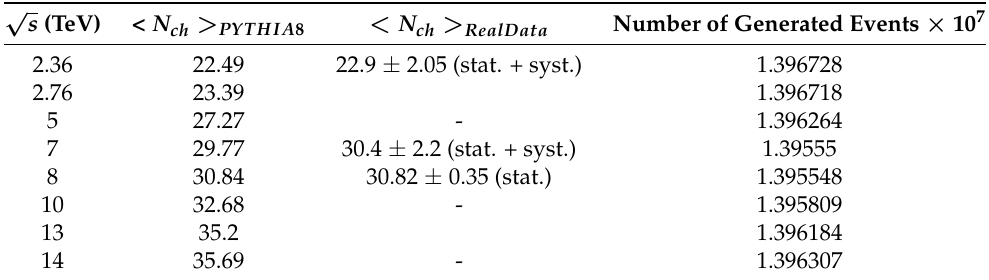
Table 1. The number of events generated by PYTHIA with at least one charged particle and a minimum p T > 0.1 GeV of and comparison with real data at some energies [6,25]. √ s (TeV) < N ch > PYTHIA 8 < N ch > RealData Number of Generated Events × 10 7